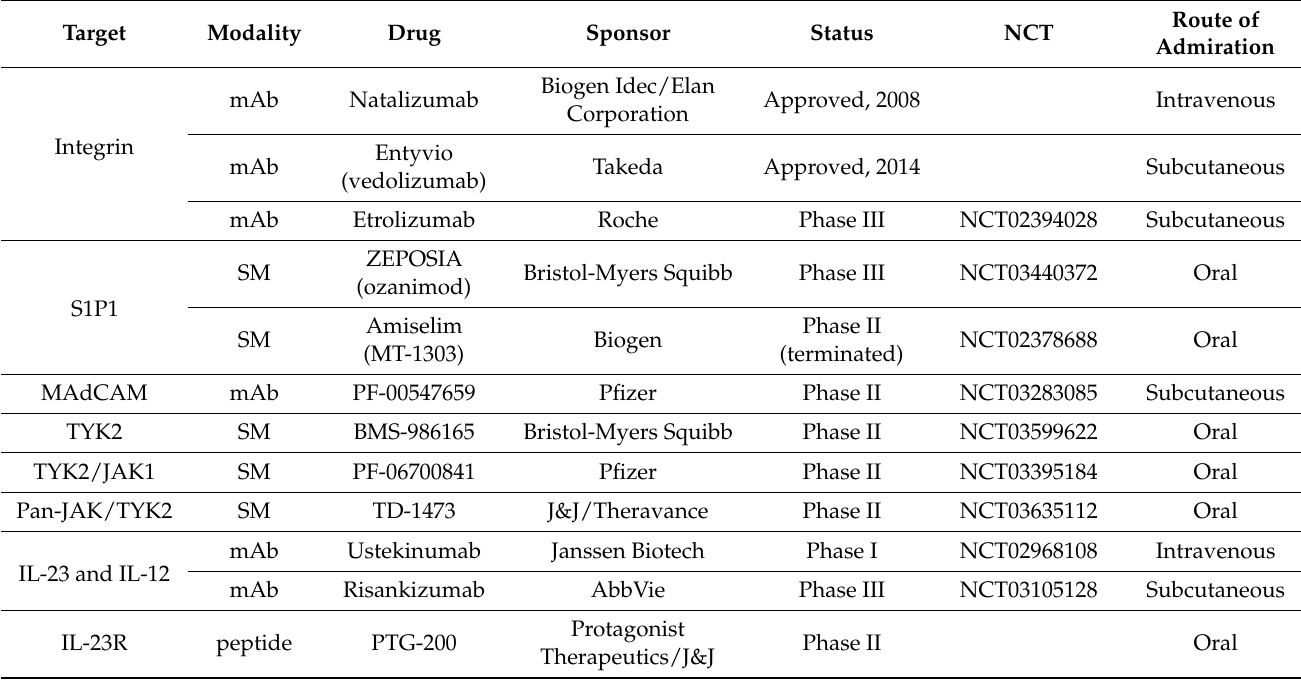
Table 7. Approved and investigational biologics and small molecules for